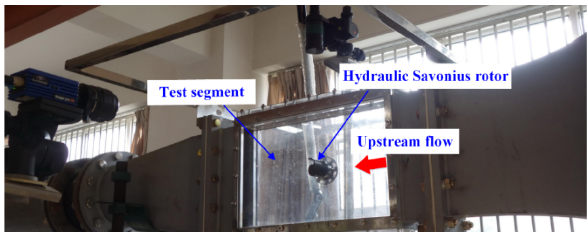
Figure 14. Savonius rotor installed in the test section of a water tunnel.